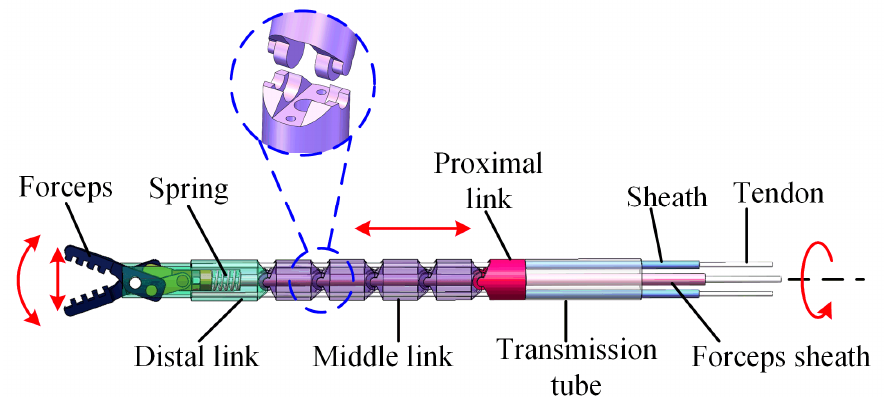
Figure 2. The DoFs and mechanism structure of the manipulator.